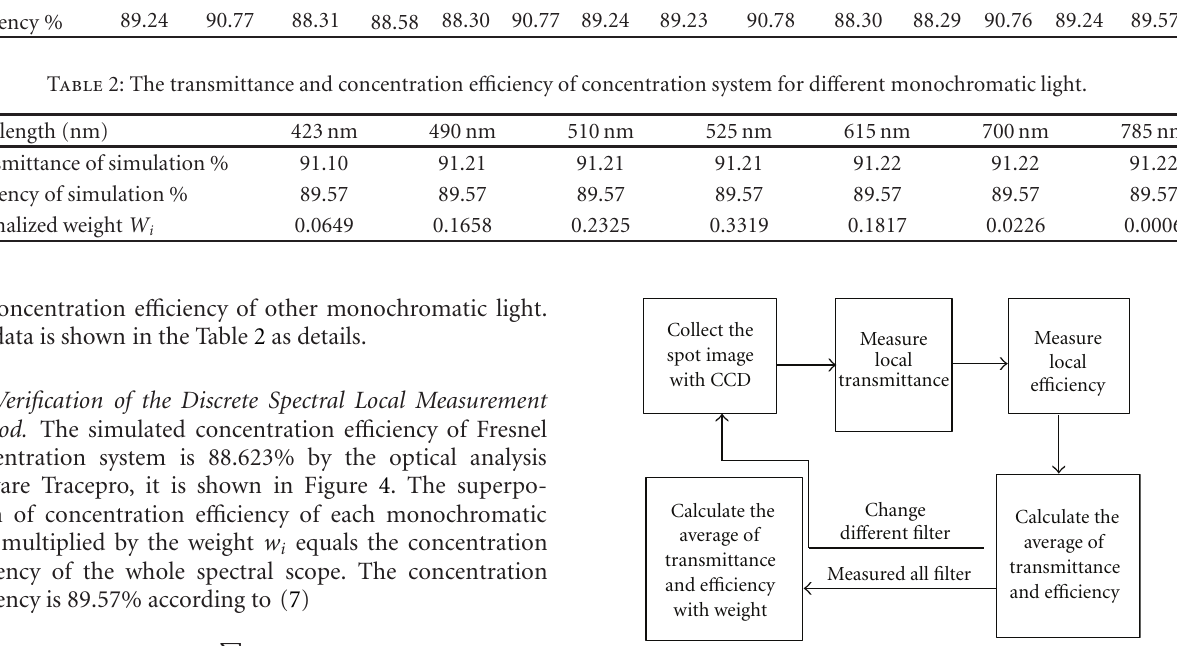
Figure 6: The flow chart of experimental test.